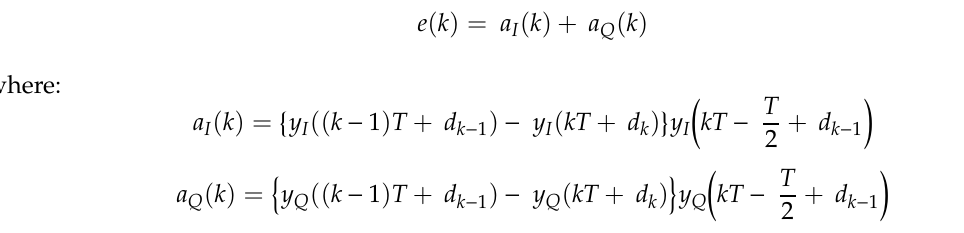
Figure 7. Phase-domain spectral density of different contributors.